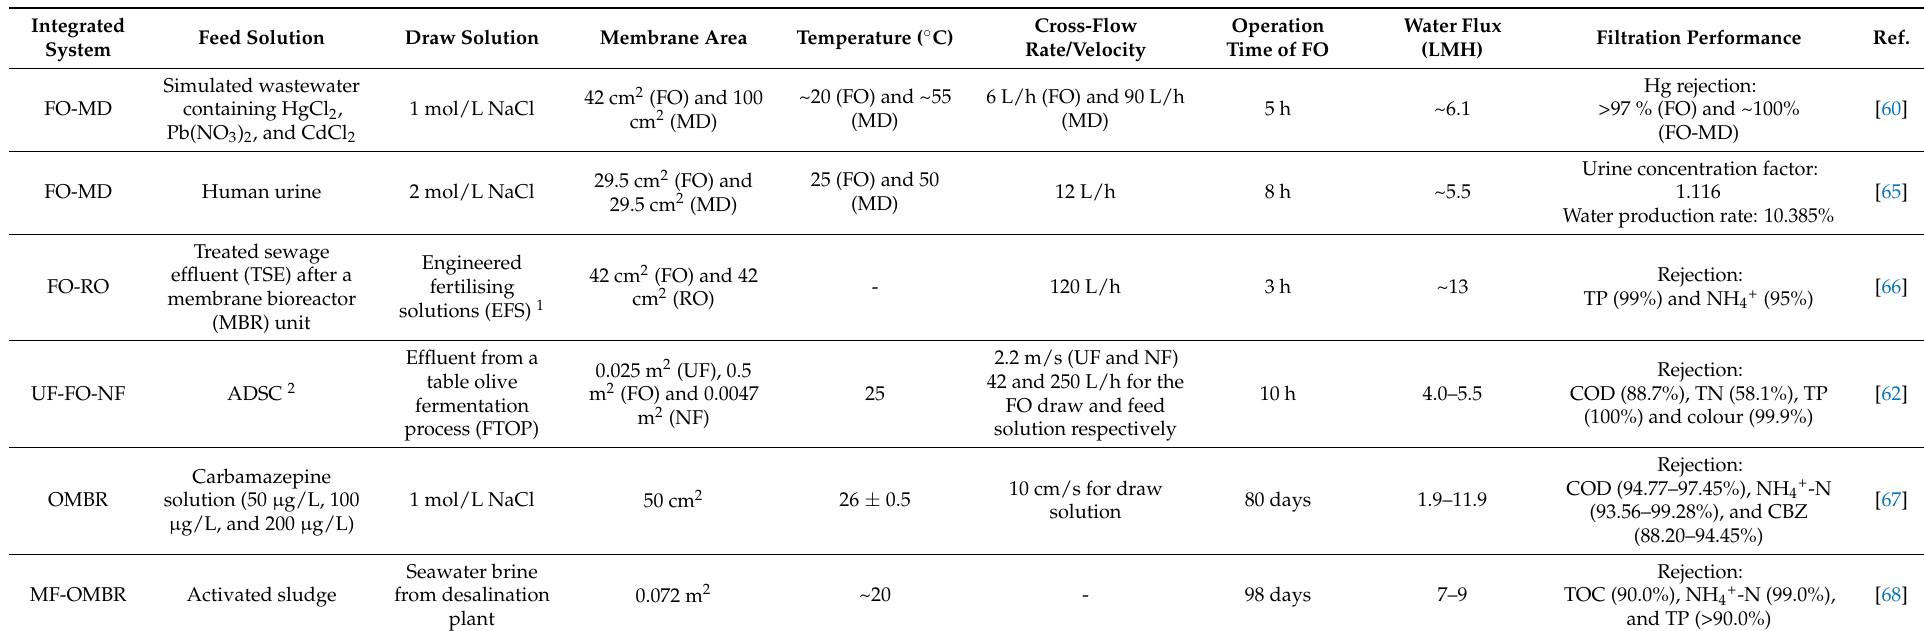
Table 3. The integration of FO with other water treatment